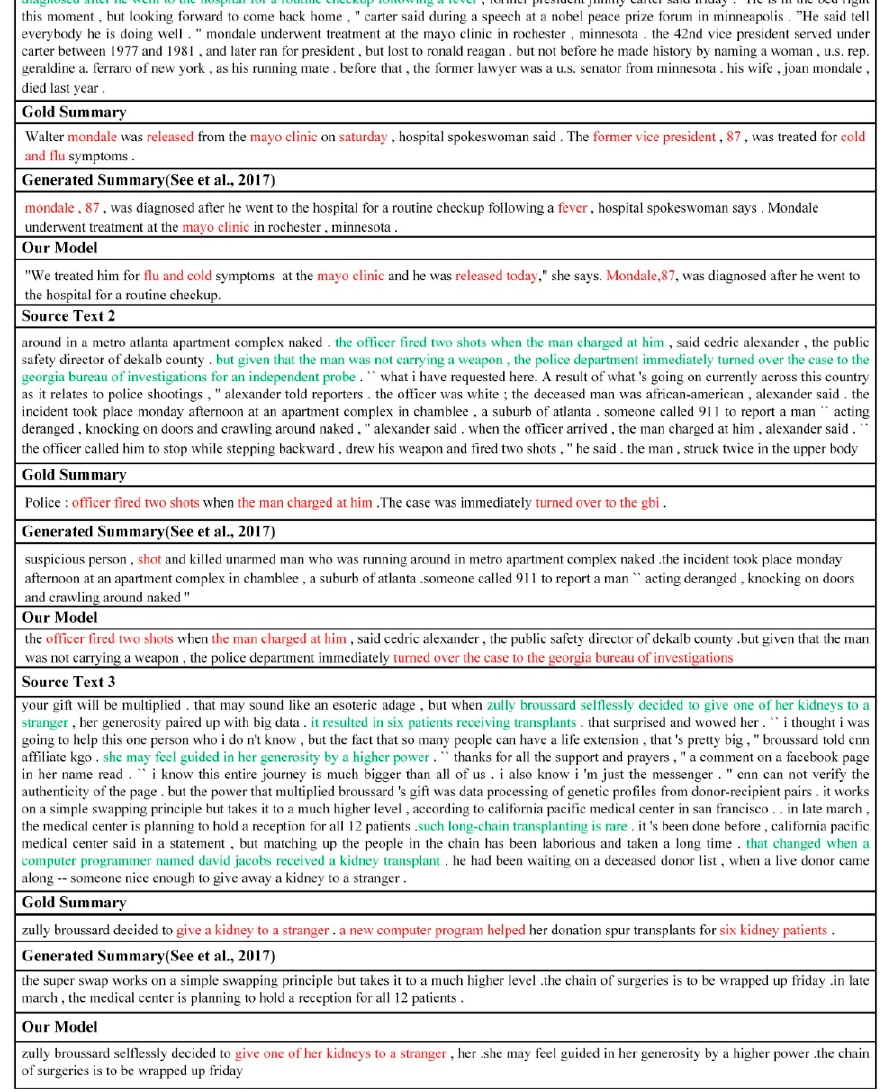
Figure 4. Examples of abstractive summarization. Green font is the key information of the source text and red font represents the effective information generated by the abstractive model. The source text (1–3) represents original texts, the gold summary is the reference summary, the generated summary is the summary by the model of See et al. [16] and our model represents the summary by our proposed model. Table 7. Readability evaluation results. See et al. [16] is the summary generated by the model of See et al. [16] and our model is the summary generated by our model. A/B: A represents the score of the syntax and B indicates the score of the grammar.